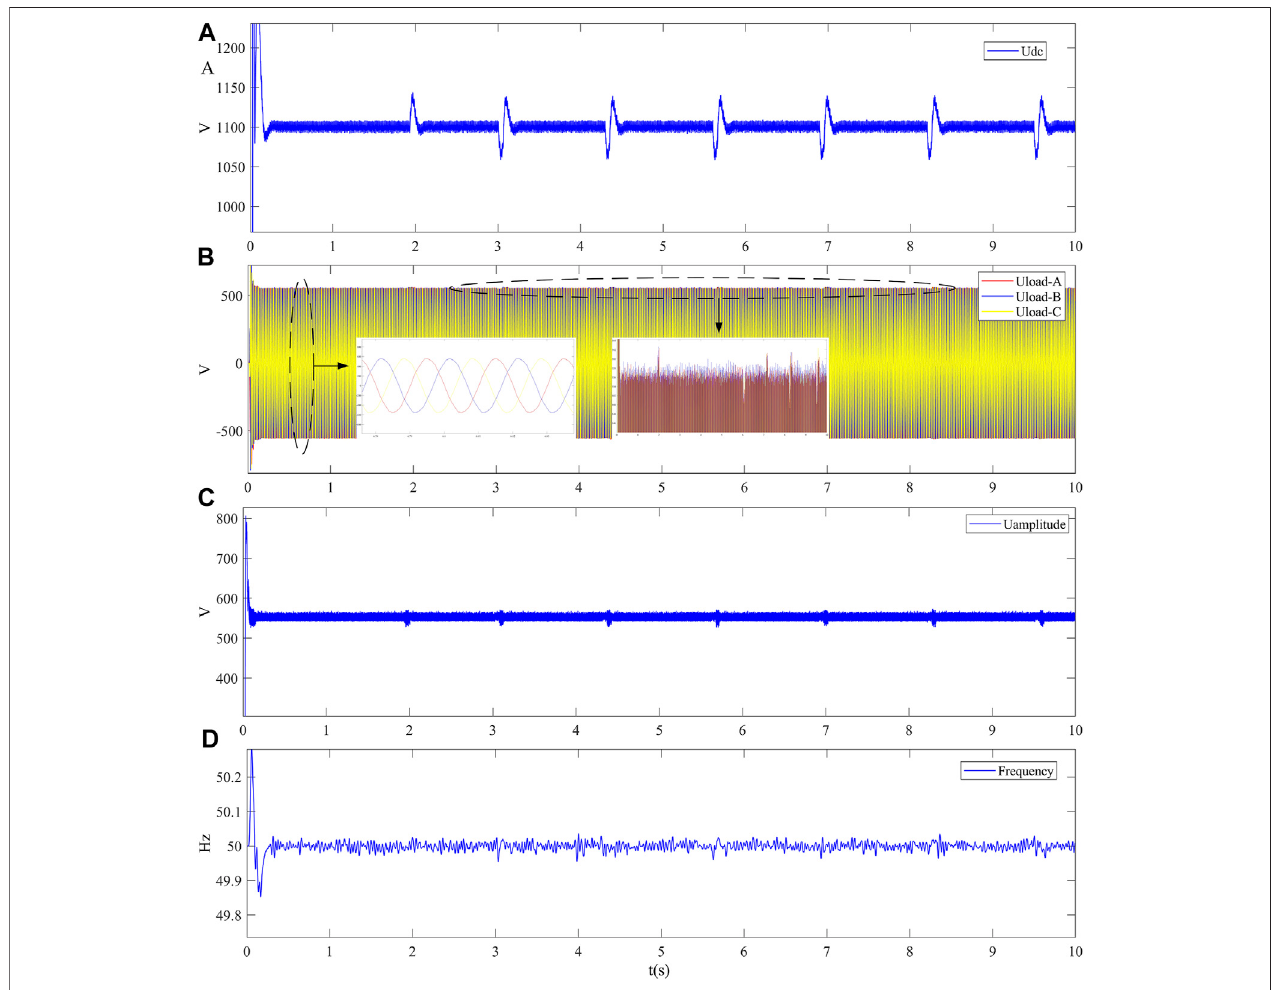
FIGURE 8 | The dc-link voltage, line-side voltage, and frequency in case 1. (A) The dc-link voltage (B) Detailed three-phase line-side voltage (C) Line-side voltage amplitude (D) line-side frequency.